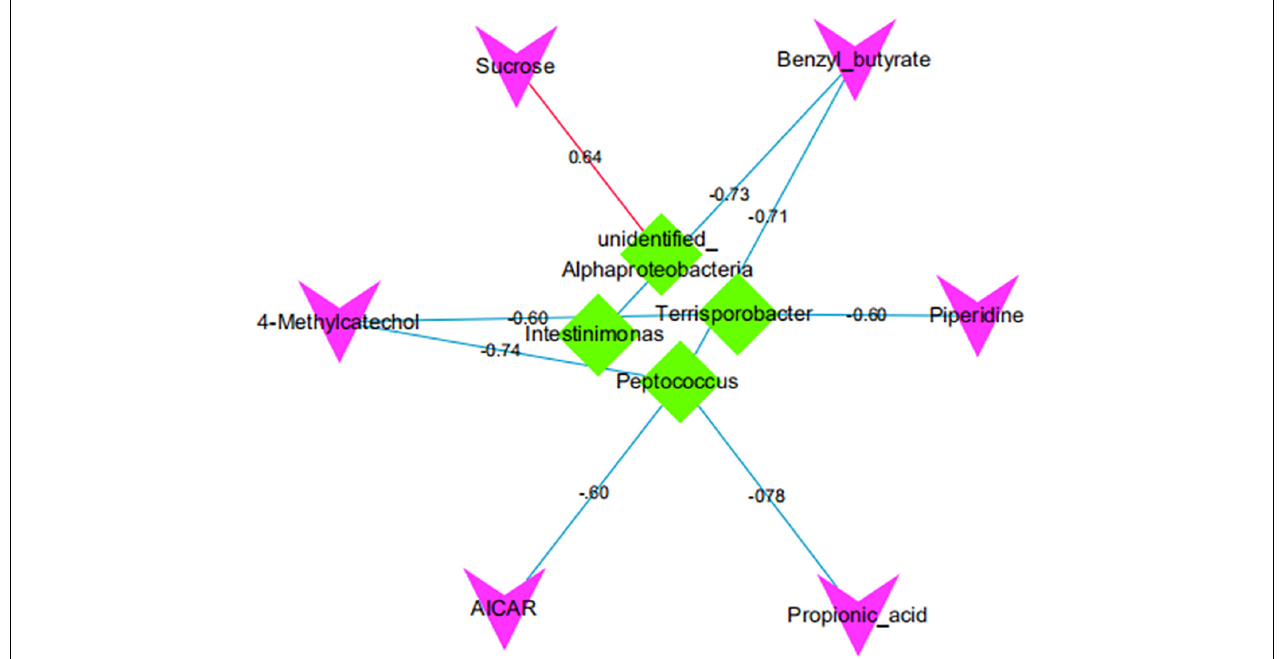
FIGURE 12 | The correlation network map of differential intestinal microbiota and metabolites. Red/green indicates that the shape represents metabolite/bacteria, red/blue lines represent positive/negative correlation, and numbers represent correlation coefficients.